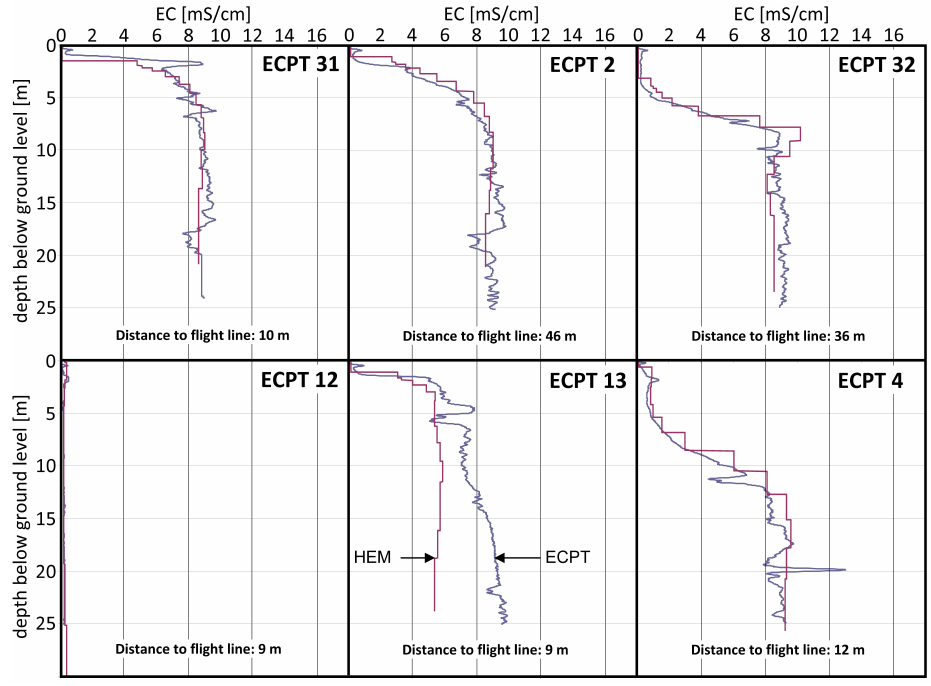
Fig. 7. Comparison of six ECPT soundings and smooth 15-layer HEM inversion models (for location see Fig. 14).